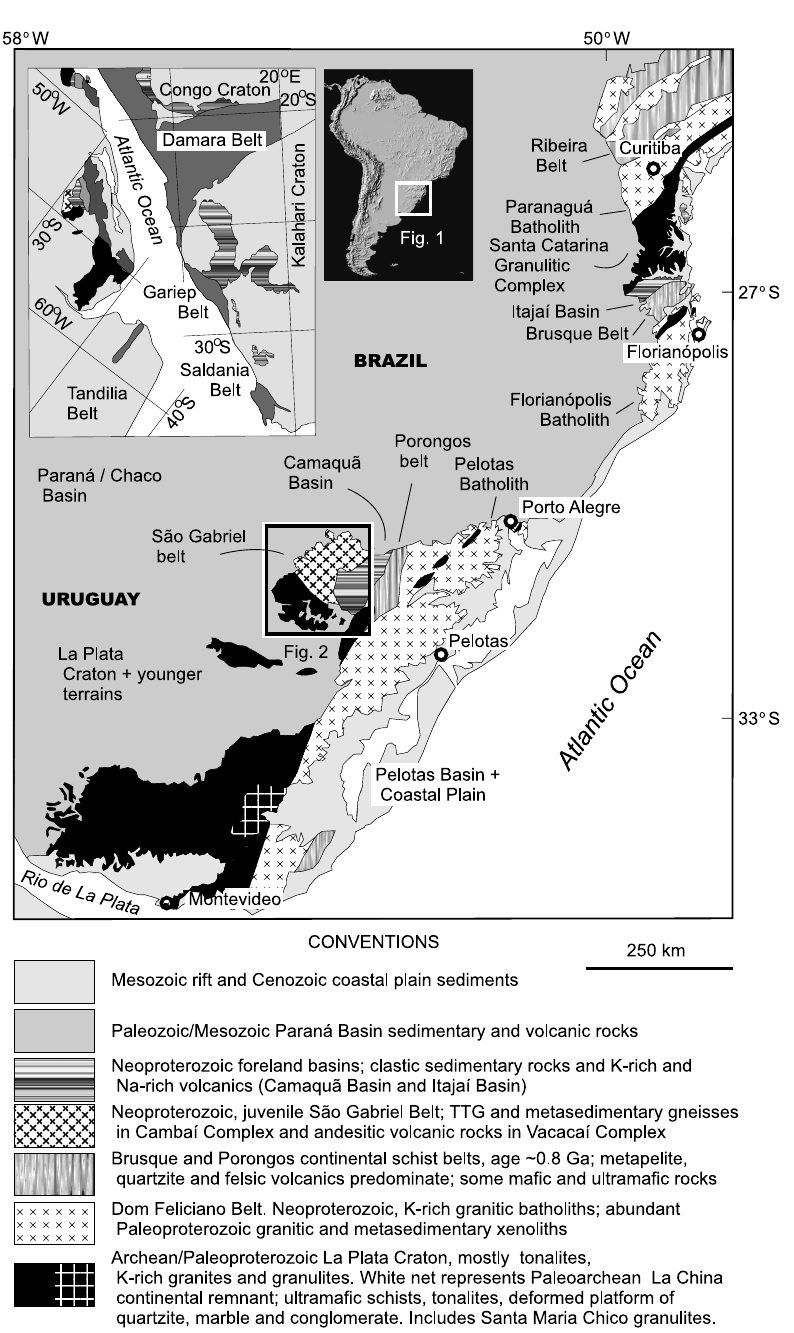
Fig. 1 – Position of studied granulitic complex in relation to regional geotectonic